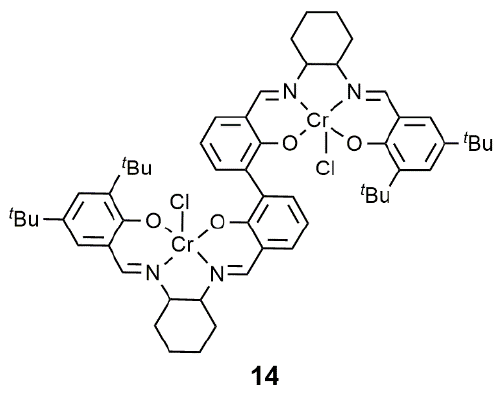
Figure 8. Dinuclear chromium catalyst 11 developed by Lu et al. [32].